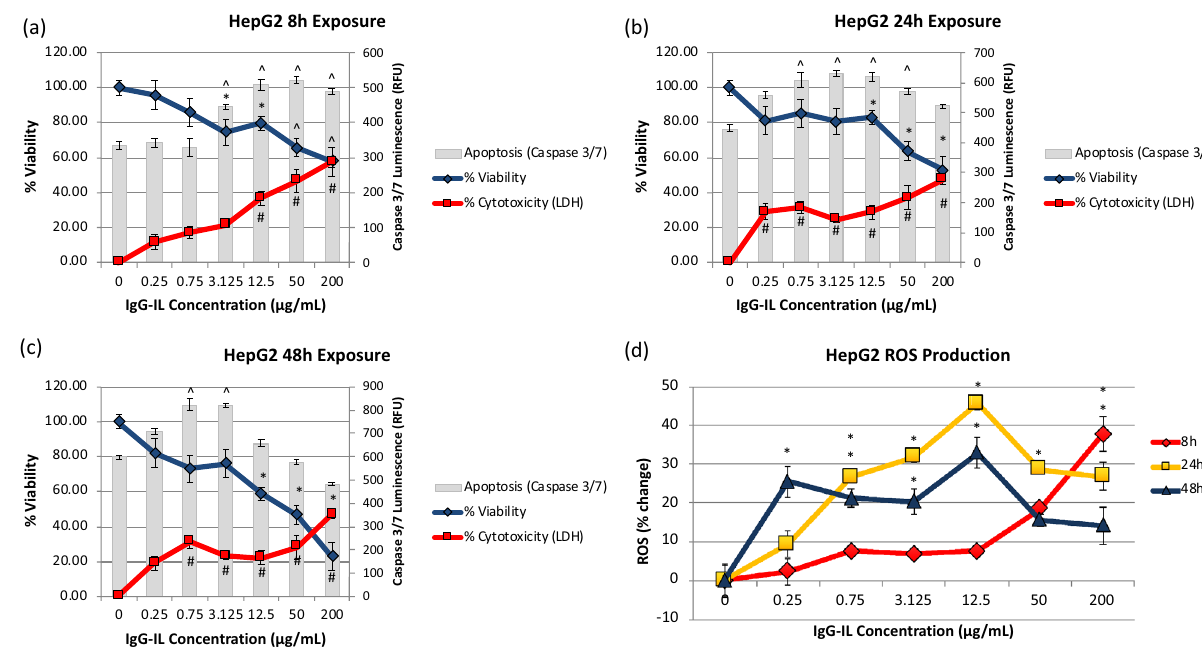
Figure 5. The viability (blue line, left y-axis), cytotoxicity (red line, left y-axis), and apoptosis (grey columns, right y-axis) results for HepG2 cells exposed to IgG-IL for 8 ( a ), 24 ( b ), or 48 ( c ) hours. Reactive oxygen species generation at 8, 24, and 48 h ( d ). Statistical significance was determined by a One-way ANOVA and a post-hoc Tukey’s Test compared to no treatment, at a confidence of 95% for n = 3, r =